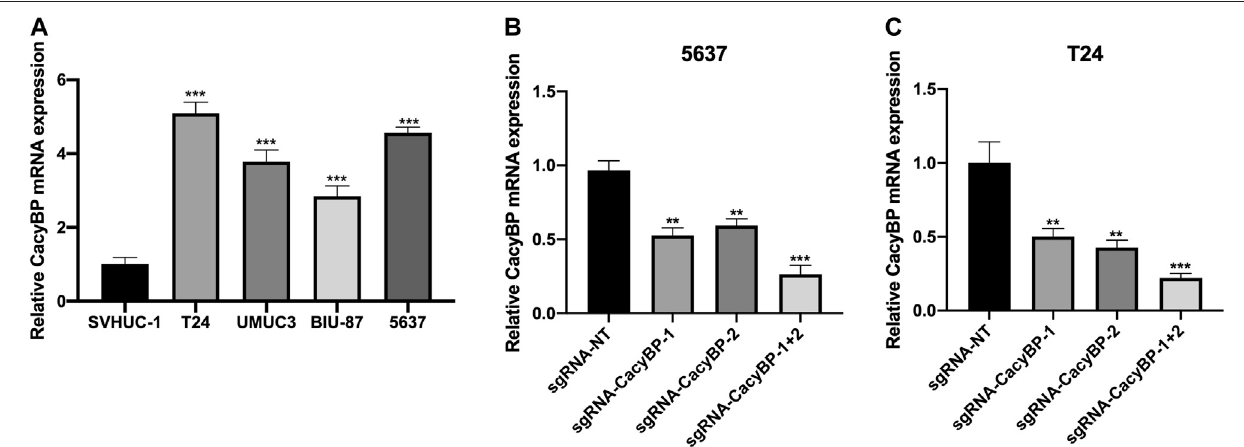
FIGURE2| CRIPSR/dCas9-KRABdecreasedtheexpressionlevelofCacyBPinbladdercancercells (A) TheexpressionlevelofCacyBPinbladdercancercelllines (T24, UMUC3, BIU-87 and 5,637) and normal urothelial cells (SVHUC-1) by RT-qPCR (B) The expression level of CacyBP in 5,637 cells after transfected with dCas9- KRAB and sgRNAs for 24 h by RT-qPCR (C) The expression level of CacyBP in T24 cells after transfected with dCas9-KRAB and sgRNAs for 24 h by RT-qPCR. ** p < 0.01, *** p < 0.001.